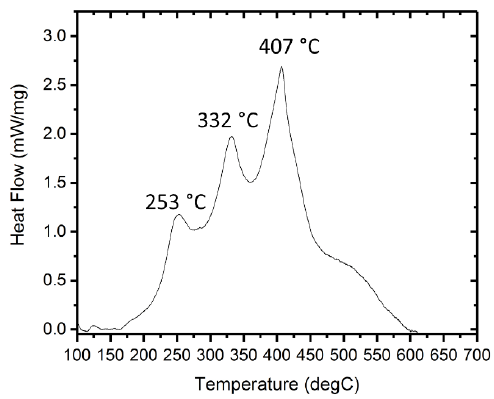
Figure 4. DSC measurement of Ni/Al RMFs.